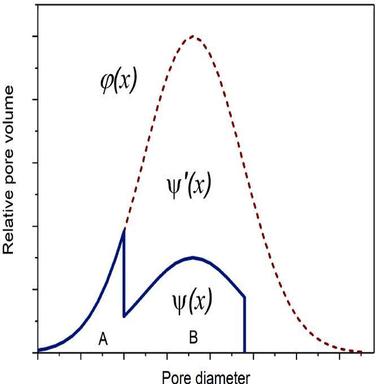
Schematic showing PSD ϕ(x) (broken line) and the phase equilibrium, attained in this pore system at a temperature T along the melting branch, between the pores containing only liquid phase (these pores have PSD ψ(x) shown by the solid line) and the pores containing only ice phase (these pores have PSD ψ' (x) = ϕ(x)− ψ(x)). The function ψ(x) is composed of two parts, A and B, in which the liquid phase results due to nucleation-mediated and phase growth processes, respectively.